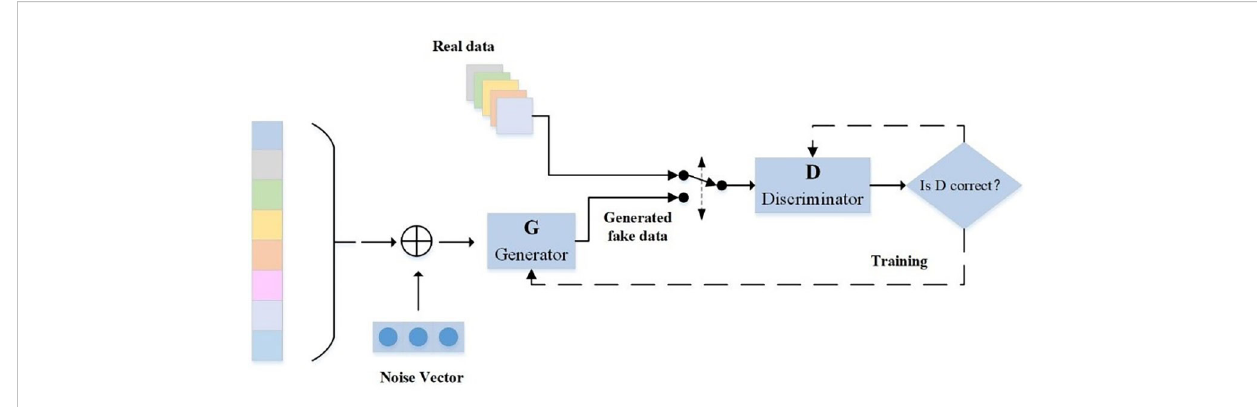
FIGURE 1 Basic structure of generative adversarial